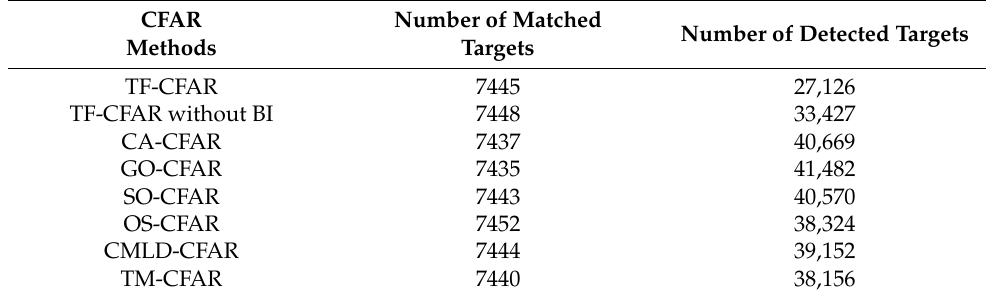
Table 5. Comparison Between detected targets under approximately equal numbers of matched targets on 25 September 2015.